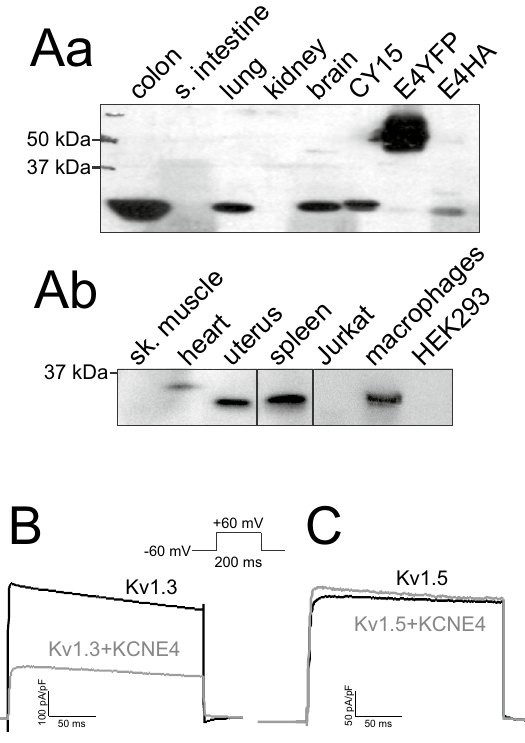
Figure 1. KCNE4, which specifically regulates Kv1.3, is differentially expressed in tissues and leukocytes. ( A ) Protein expression of KCNE4 in different rat tissues and cell lines. HEK-293 cells were used as negative control, and HEK cells transfected with KCNE4-YFP (E4YFP) and KCNE4-HA (E4HA) were used as positive controls. Different western blots with the same KCNE4-YFP and KCNE4-HA controls from different origins were merged for better visualization. Fifty micrograms of protein was loaded in each lane, and filters were immunoblotted with anti-KCNE4 antibody. Differential β-actin expression among tissues and cell lines (not shown) invalidated this protein as a control. Therefore, a KCNE4 abundance comparison among samples should not be considered. The results must be considered as qualitative data. Representative cropped blots, clearly separated by vertical black lines, are shown only for qualitative purposes. ( B , C ) Representative patch-clamp recordings of HEK-293 cells transfected with Kv1.3 and Kv1.5 in the absence or presence (+ KCNE4) of KCNE4. Cells were hold at -60 mV and voltage-dependent K + currents were elicited by applying 200 ms depolarizing pulses to + 60 mV. (B) Kv1.3 + /- KCNE4. ( C ) Kv1.5 + /- KCNE4. Gray lines, presence of KCNE4 (+ KCNE4); black lines, absence of KCNE4. Data analysis was performed using FitMaster (HEKA) and SigmaPlot 10.0 software (Systat